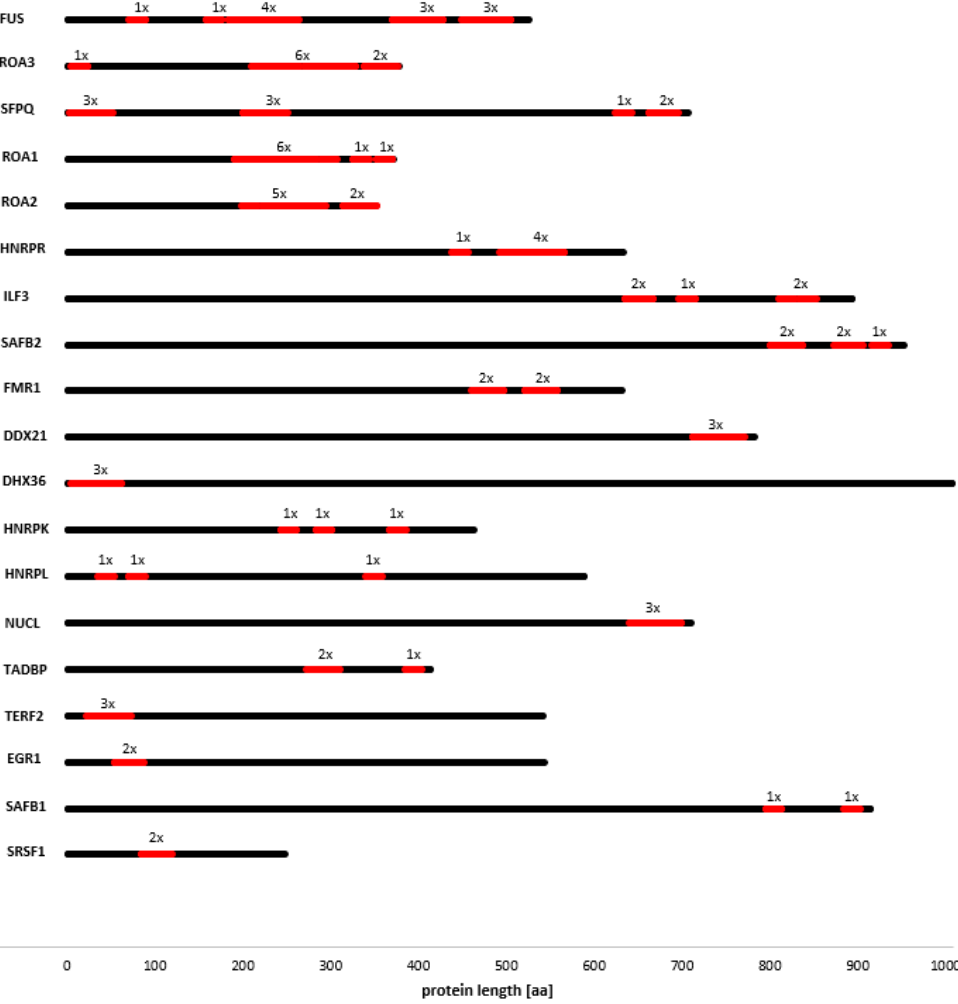
Figure 6. Location of the NIQI motifs in quadruplex binding proteins containing at least two motifs.